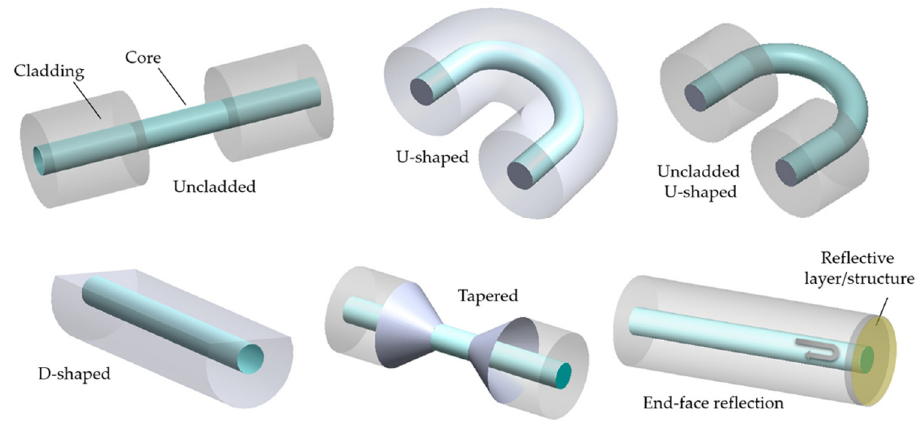
Figure 3. Schematization of geometry-modified OF configurations for biosensing.